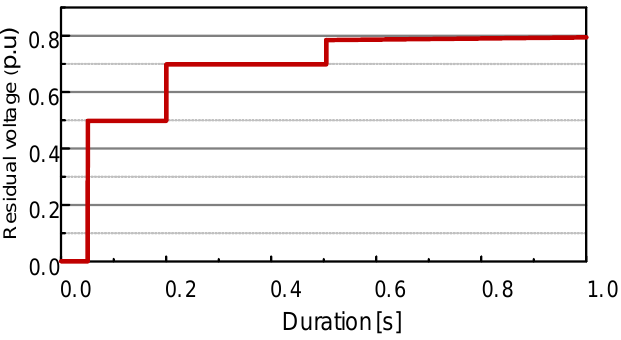
Figure 2. Sensitive equipment SEMI F47 curve.